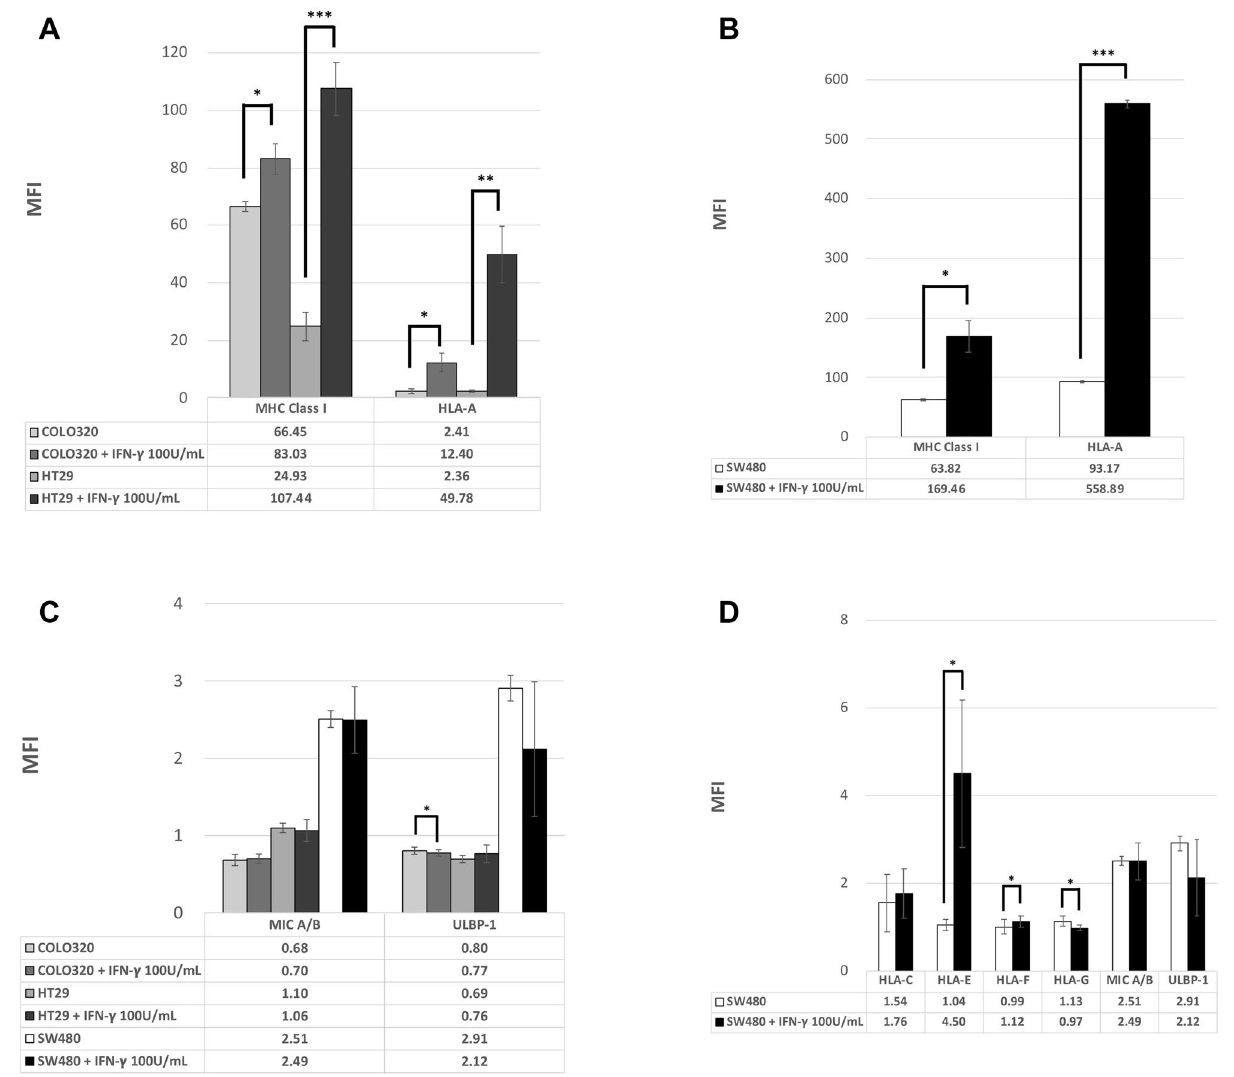
Figure 1. ( A ) Mean fluorescence intensity (MFI) for MHC class I and HLA-A expressed on two colon cell lines in response to IFN-γ after 48-h exposure. (* P < 0.05, ** P < 0.01, *** P < 0.001). ( B ) Mean fluorescence intensity (MFI) for MHC class I and HLA-A expressed on SW480 cell lines in response to IFN-γ after 48-h exposure. (* P < 0.05, ** P < 0.01, *** P < 0.001). ( C ) Mean fluorescence intensity (MFI) for NK cell ligands expressed on three colon cell lines in response to IFN-γ after 48-h exposure. (* P < 0.05, ** P < 0.01, *** P < 0.001). ( D ) Mean fluorescence intensity (MFI) for MHC class I alleles and NK cell ligands expressed on SW480 cell lines in response to IFN-γ after 48-h exposure. (* P < 0.05, ** P < 0.01, *** P <